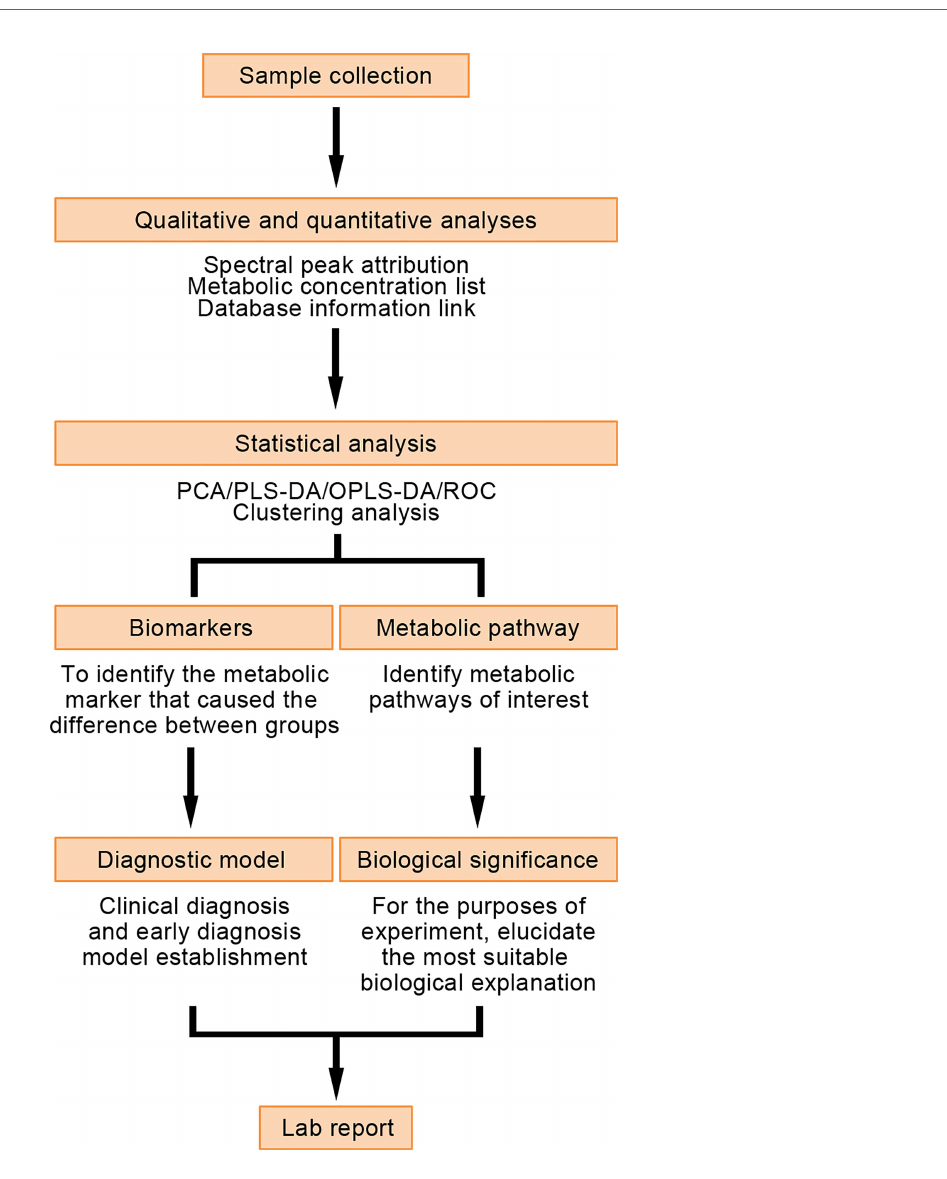
FIGURE 5 | Detection process and application of